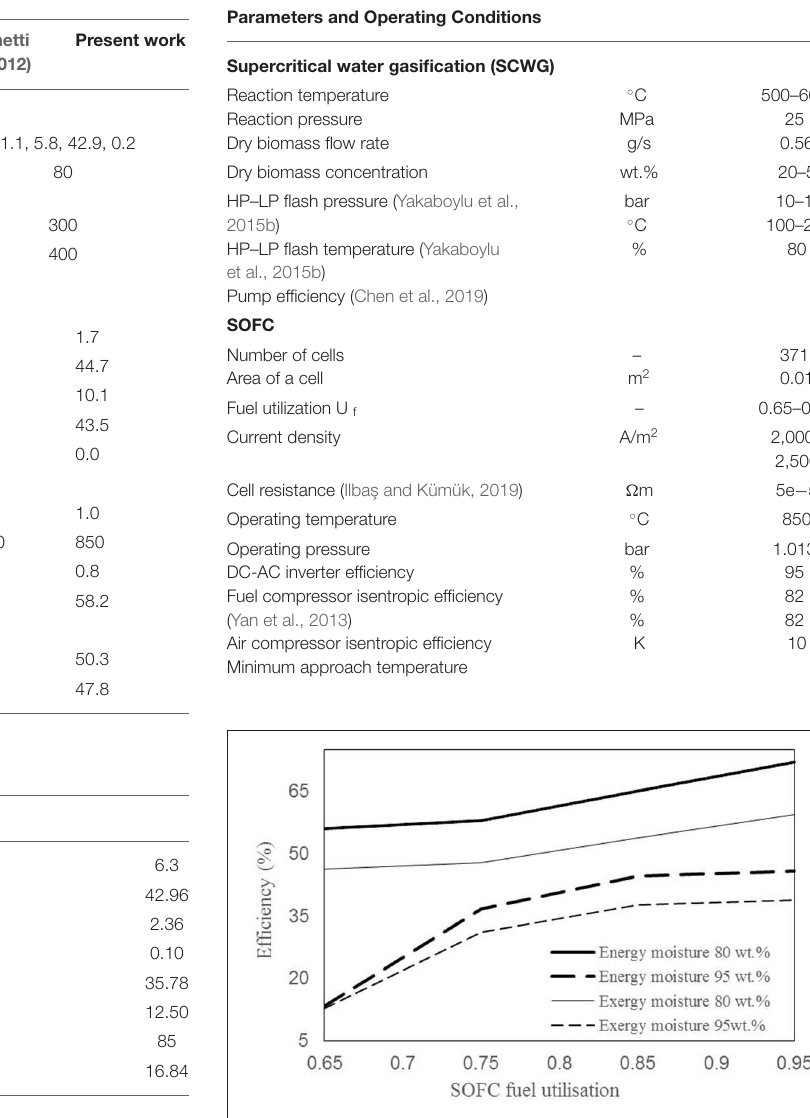
FIGURE 5 | Efficiency of the supercritical water gasification (SCWG) solid oxide fuel cell (SOFC) system as a function of U f and biomass moisture content.